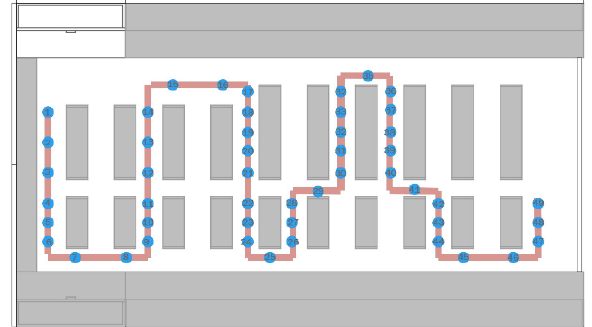
Figure6 schematic diagram of geomagnetic fingerprint